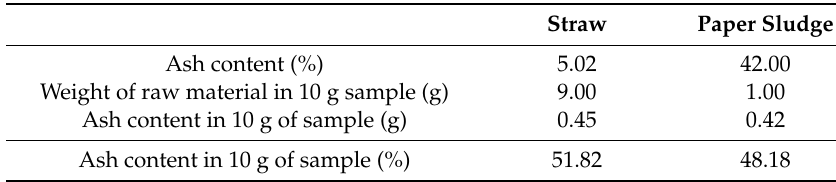
Table 6. Ash content in 10 g of SPS-90/10 sample.